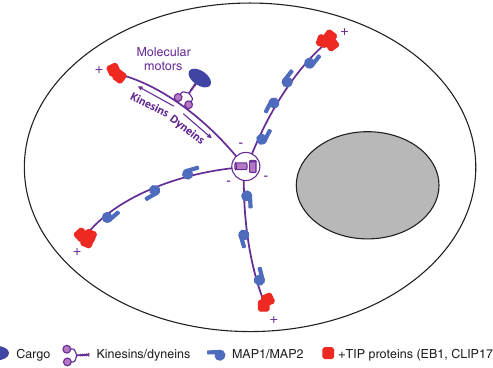
Figure 2: Organization of the MT network and expected localization of